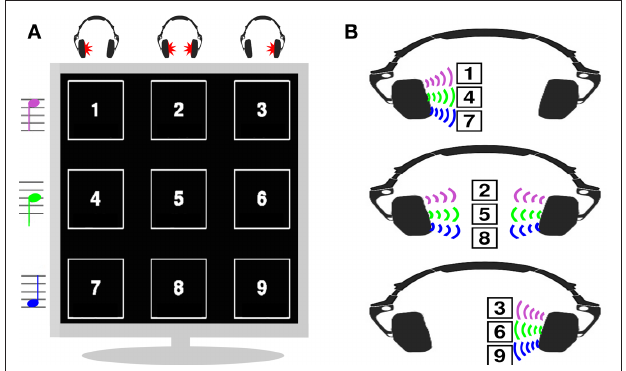
FIguRE 2 | Visualization of the nine auditory stimuli, varying in pitch and direction. The 3 × 3 design (A) was shown on the screen. (B) Distribution of the nine stimulus tones to the stereo channel of the